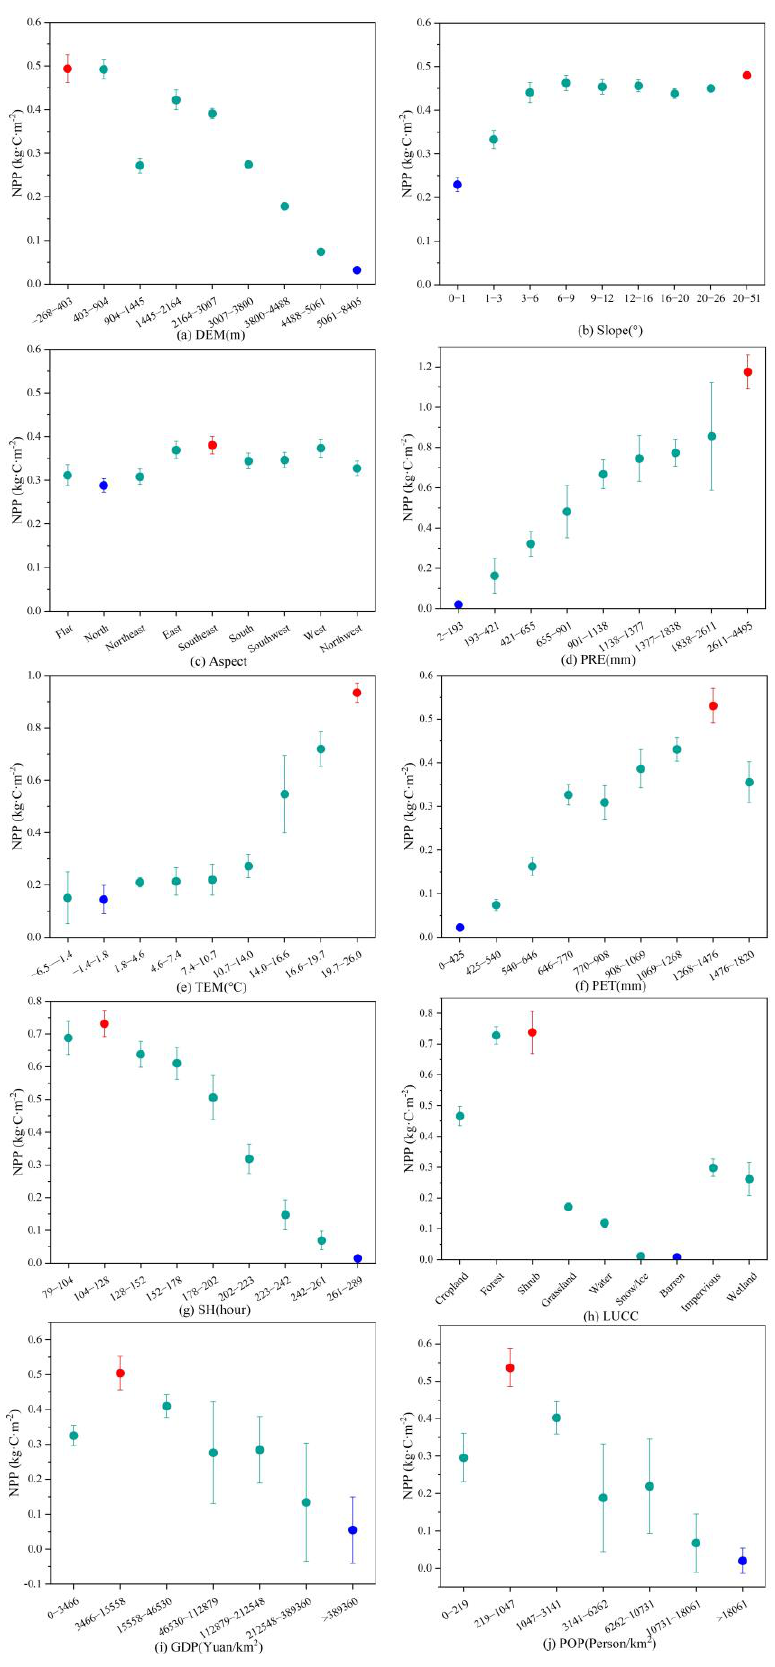
Figure 8. Risk detector for optimal ranges of influencing factors of NPP.